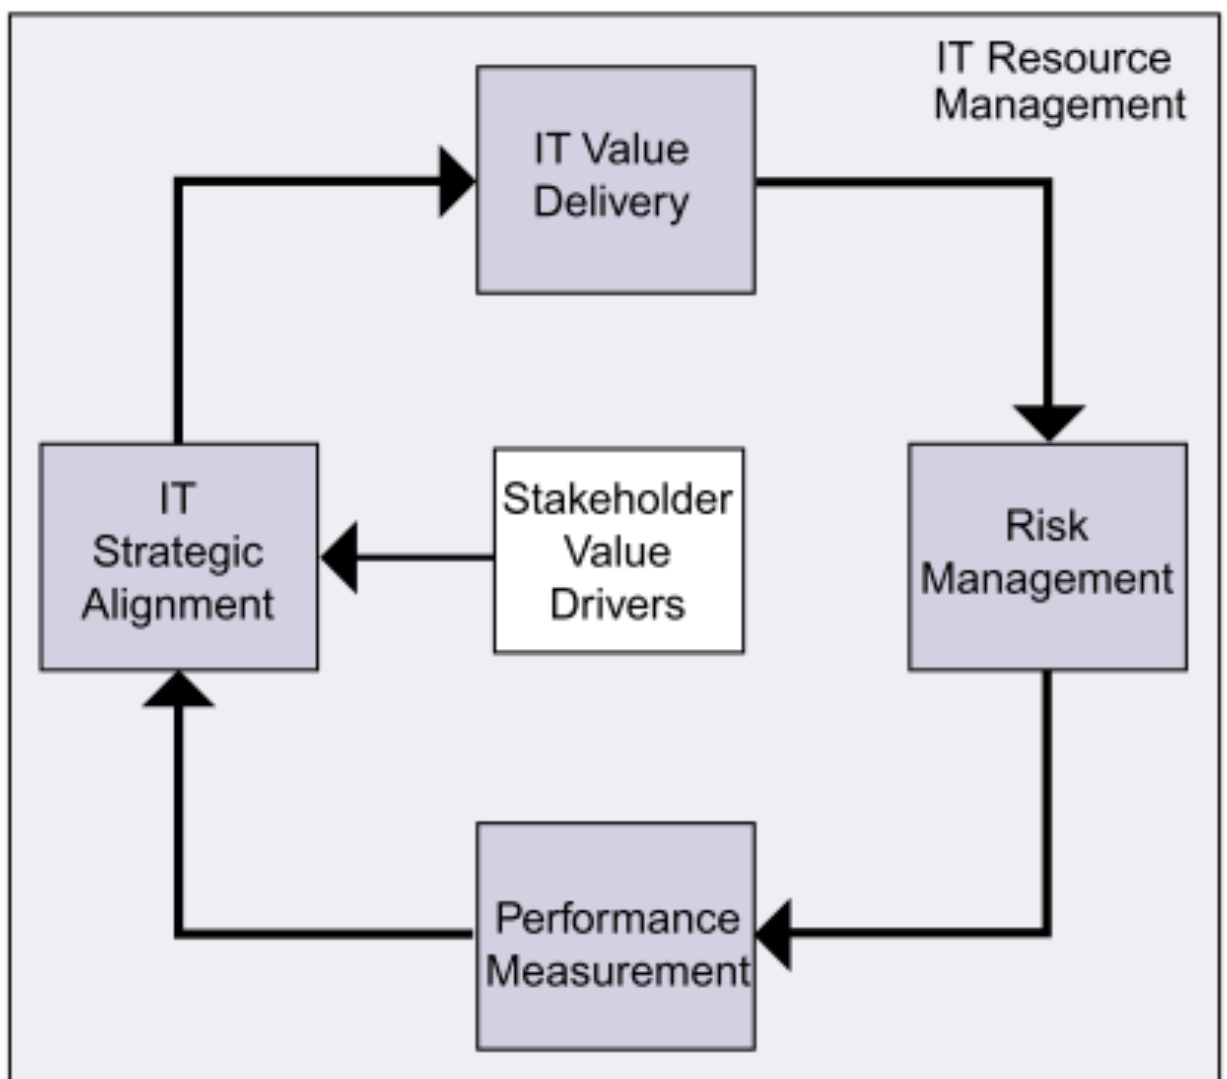
Figure 2. IT governance framework. The five areas of governance. The system follows the five areas driven by the stakeholders needs. The two outcomes (IT delivery and risk management) and three drivers (IT strategic alignment, resource management, and performance measurement) [9].